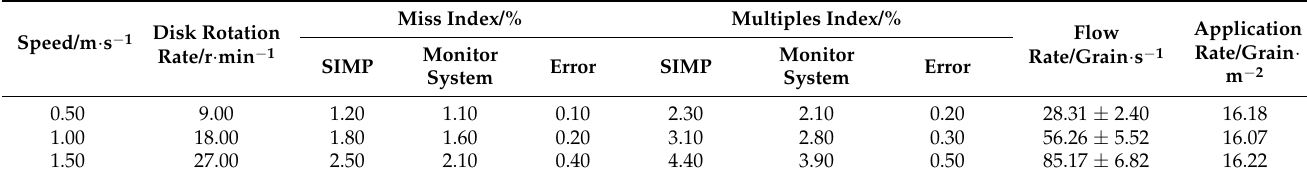
Table 2. Statistics results of static experiment.